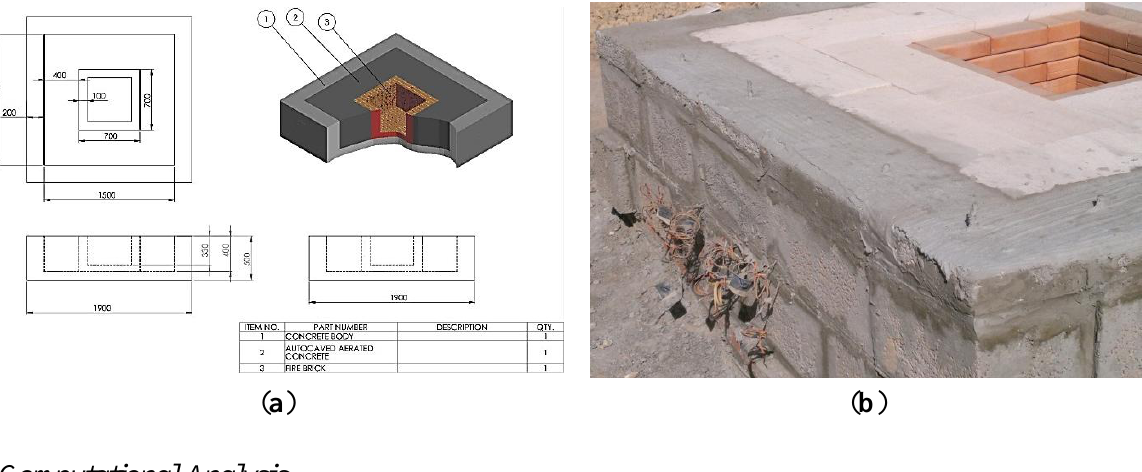
Figure 2. Description of the thermal energy storage bin experimental apparatus: ( a ) engineering drawing, showing the dimensions of the bin and ( b ) photograph of the actual bin, showing the thermocouple